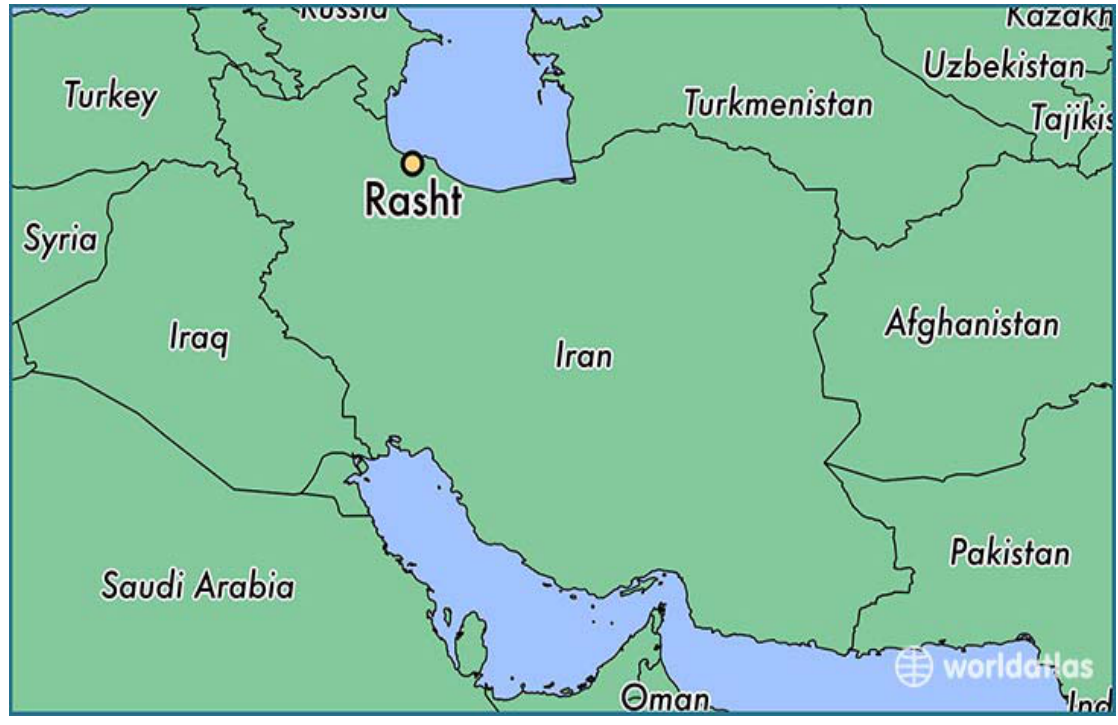
Figure 2. Location of Rasht County